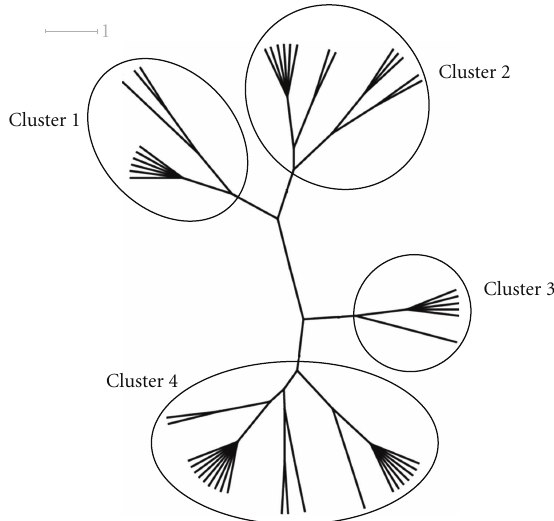
Figure 1: Cluster tree showing four major clusters (Cluster 1, Cluster 2, Cluster 3, and Cluster 4), each cluster signifies a di ff erent ligand footprint on the protein-ligand complex. The protein-ligand interactions within the cluster are conserved; they vary between the clusters. The subclusters within a cluster also show similar interaction modes with slight variation in the binding pattern.